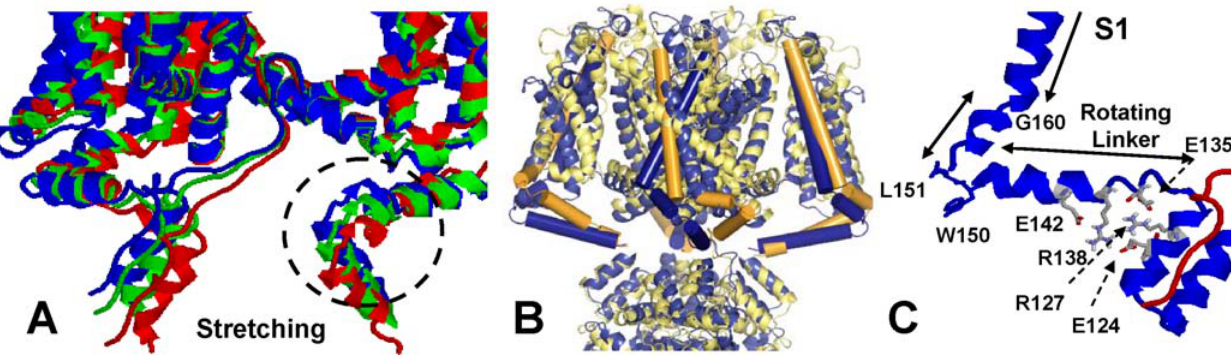
Figure 4. (A) Stretching of inactivating peptide and (B) hyperpolarized state (yellow). For comparison, both models are superimposed at the pore complex with the open crystal structure. (A) Three snapshots are shown, in blue is the starting structure (Fig. 3A and blue chain in 3B) from which we computed the elastic modes in the server elNemo [22], green is an intermediate snapshot and in red is the final state. Sketch shows a 10 A˚ displacement but we do not have corroborating evidence to estimate an absolute number. For clarity, only two consecutive monomers of the channel and the bound peptides are shown. The dashed circles indicate the helix-turn-helix motif that widens during stretching. The final state in (A)- red (also shown in green in Fig. 2B) is the starting structure used in to model the hyperpolarized state (red chain in Fig. 3B). (B) Note that the T1 domain and pore (see also Fig. 3B) superimpose quite well. Both S1 and the S1-T1 linker are shown as cylinders to emphasize the rotation of S1 and the ratchet motion of the linker that is in a more extended conformation (see, also, Fig. 3B-green model). (C) Detailed of the S1-T1 linker and T1 domain interactions (as in Fig. 3A). Some key residues on the linker-T1 interface are shown. Note that E142 forms two H bonds with R138 which forms one H bond with T1 E124. The second H bond of E124 is with R127 that is also bonded to E135 in the